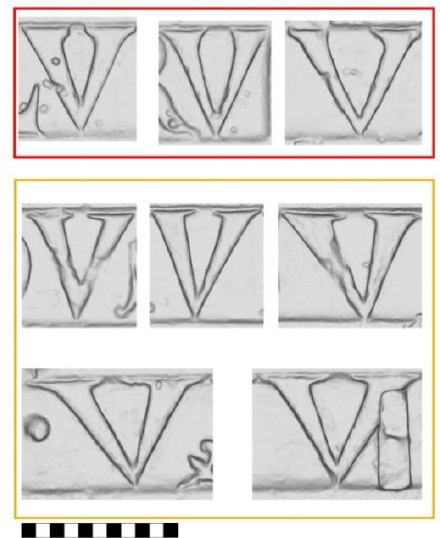
Figure 10. Table of V s, red frame: 19 th century; yellow frame: